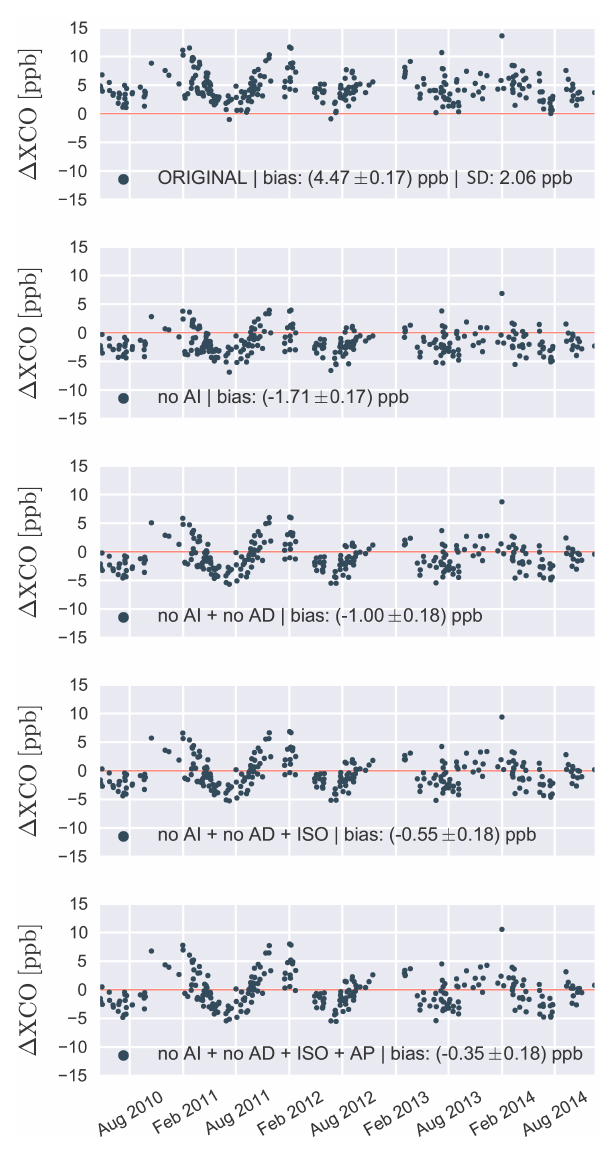
Figure 9. Daily mean absolute difference time series (NDACC– TCCON) of XCO for the standard retrievals (first panel, labelled as “ORIGINAL”), no air-mass-independent correction factor (AI) ap- plied (second panel), no air-mass-dependent correction factor (AD) applied (third panel), a modified treatment of isotopic identities ap- plied for the MIR retrieval (ISO, fourth panel), and used common a priori (AP) VMR profiles (fifth panel). Zero lines are marked red and are for eye-guidance